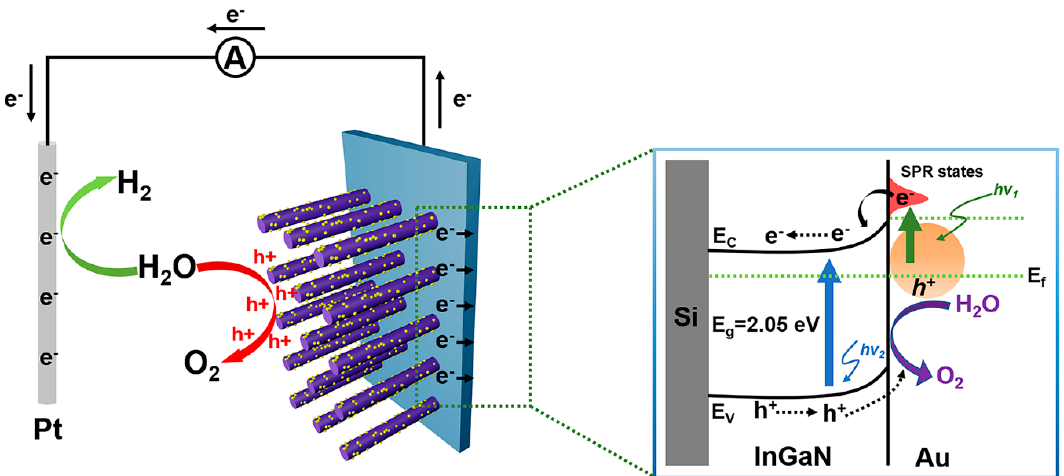
Figure 6. Schematic of mechanisms for understanding the enhanced PEC water splitting efficiency of the Au@InGaN NR